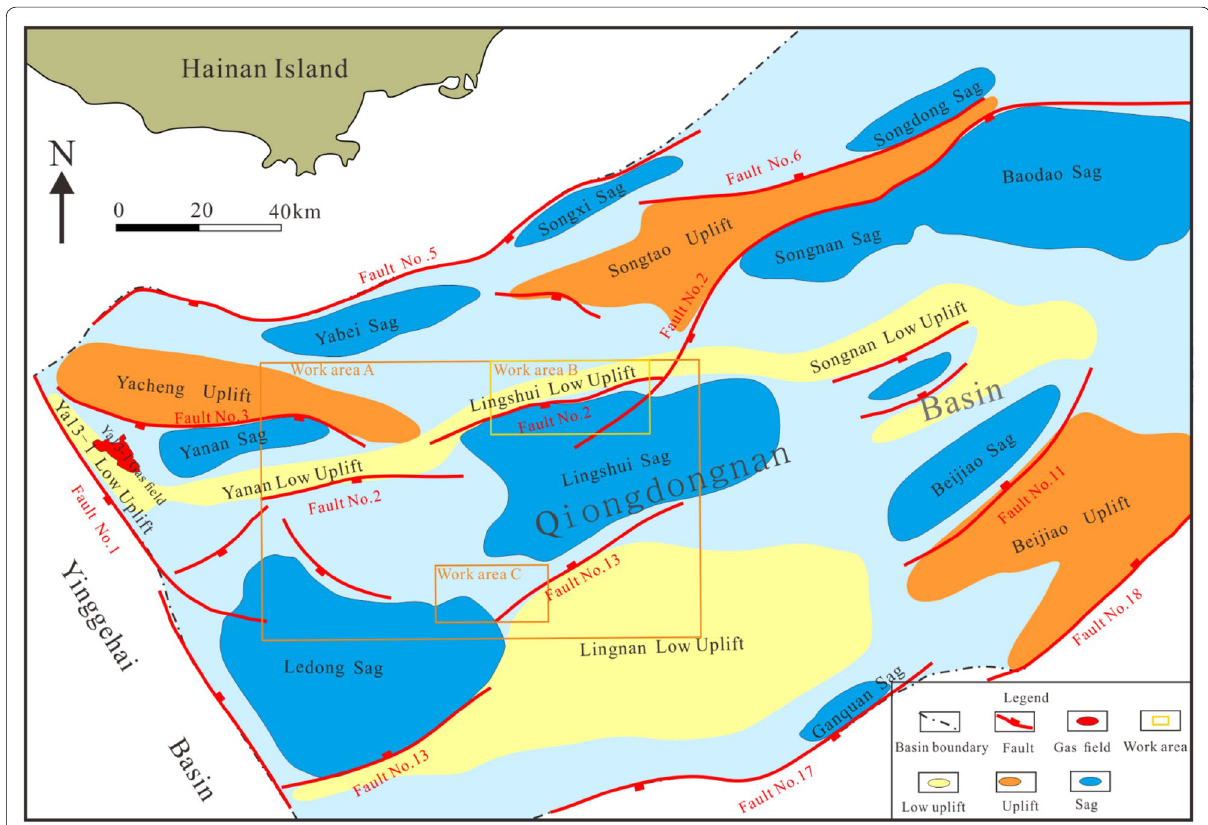
Fig. 1 Tectonic division in the Qiongdongnan